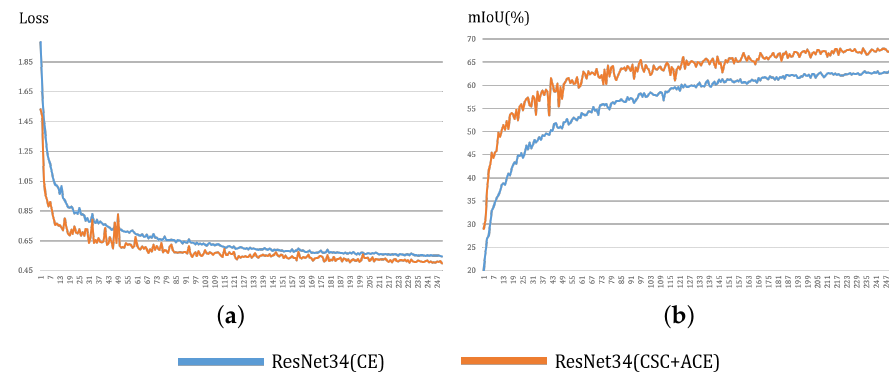
Figure 6. Effects of our distillation method on the speed of the optimization of the loss and accuracy for the Cityscapes validation set. These results were obtained for 709 × 709 cropped input images. ( a ) is cross-entropy loss graph per epoch and ( b ) is mIoU per epoch. The orange line is the result obtained using our distillation method, and the blue line (baseline) is without distillation method. Here, we adopt the Deeplab-V3 + structure, where Resnet34 is used as an encoder. The speed of the optimization of the loss and mIoU are significantly increased using our distillation method than those of the baseline